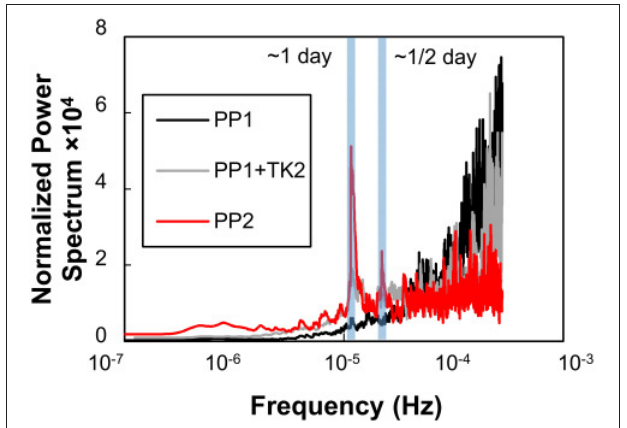
FIGURE 9 | Power spectra of CO 2 flux with PP1 (black line), PP1 with TK2 (blue line) and PP2 (red line). The spectra were normalized using the variances of CO 2 flux for the entire measurement period after each calculation. The shaded areas indicate the frequency around the 24h diurnal cycle (left) and 12.5h tidal cycle (right). Average CO 2 flux data during the entire measurement period were used to replace missing CO 2 flux data.